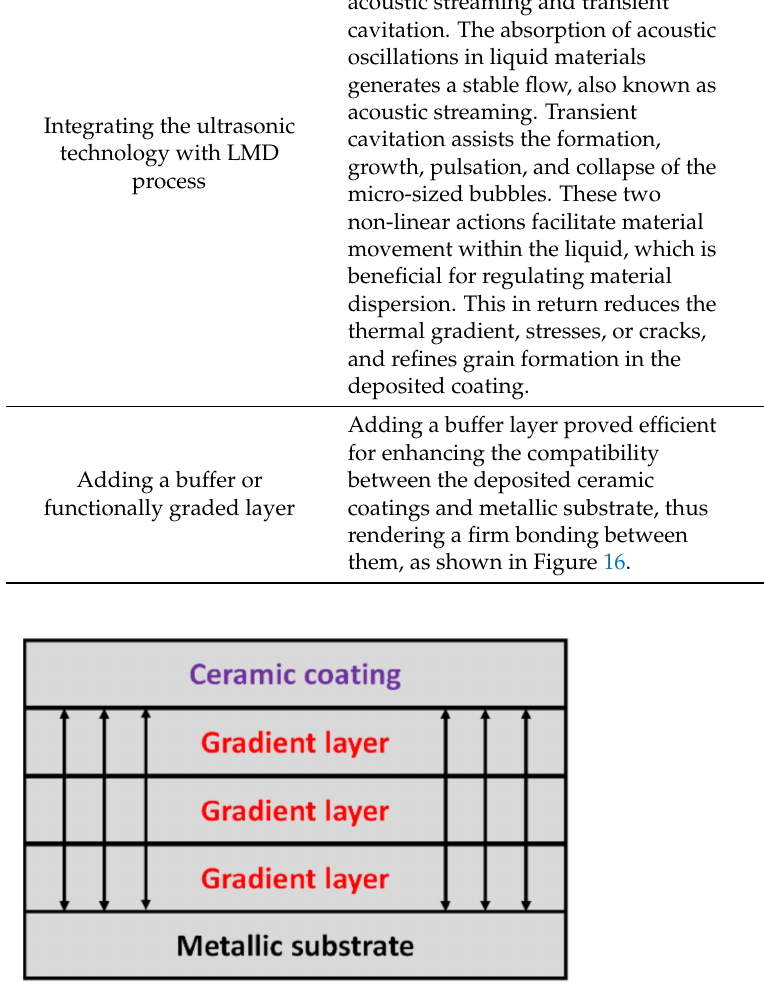
Figure 16. Inclusion of buffer or functionally graded material layer. This technique is commonly used in the medical